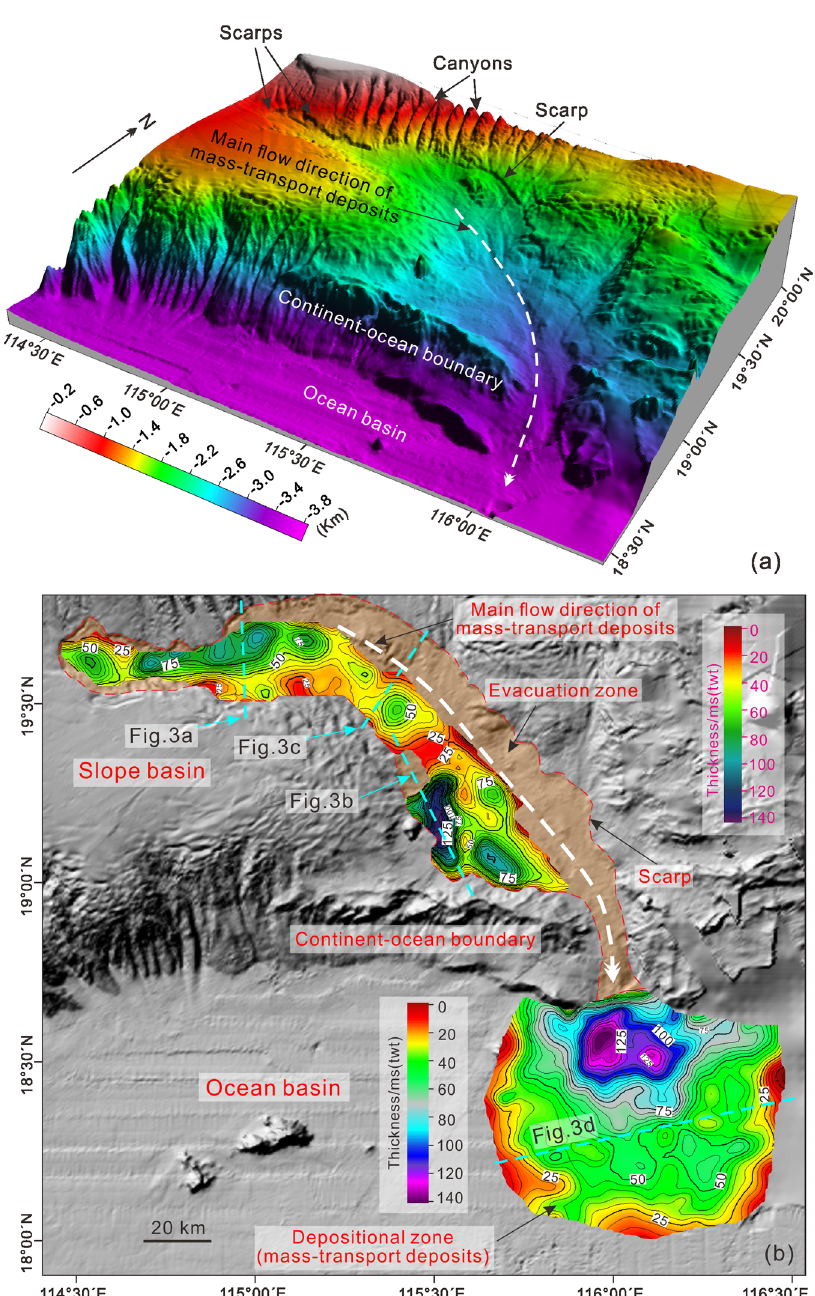
Fig. 2 3D visualization of the present-day sea fl oor and total thickness of mass-transport deposits. a 3D visualization of the present-day sea fl oor of the Pearl River Mouth Basin. Identi fi ed in the fi gure are the head and side scarps of the studied Baiyun Slide plus the continent-ocean boundary separating the slope area from the ocean basin. The main fl ow direction of failed sediment in the Baiyun Slide is shown by the white dashed line with an arrow; b total thickness of mass-transport deposits imaged by seismic re fl ection data in the study area. The sediments on the continental slope in the eastern part of Baiyun Slide were totally evacuated and deposited as a sediment fan in the ocean basin of South China Sea (marked as the depositional zone in the fi